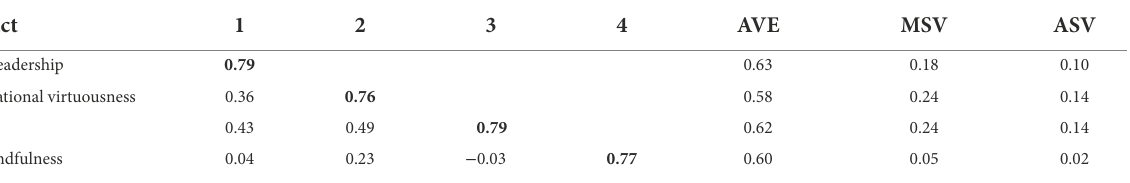
TABLE 2 Discriminant validity and convergent